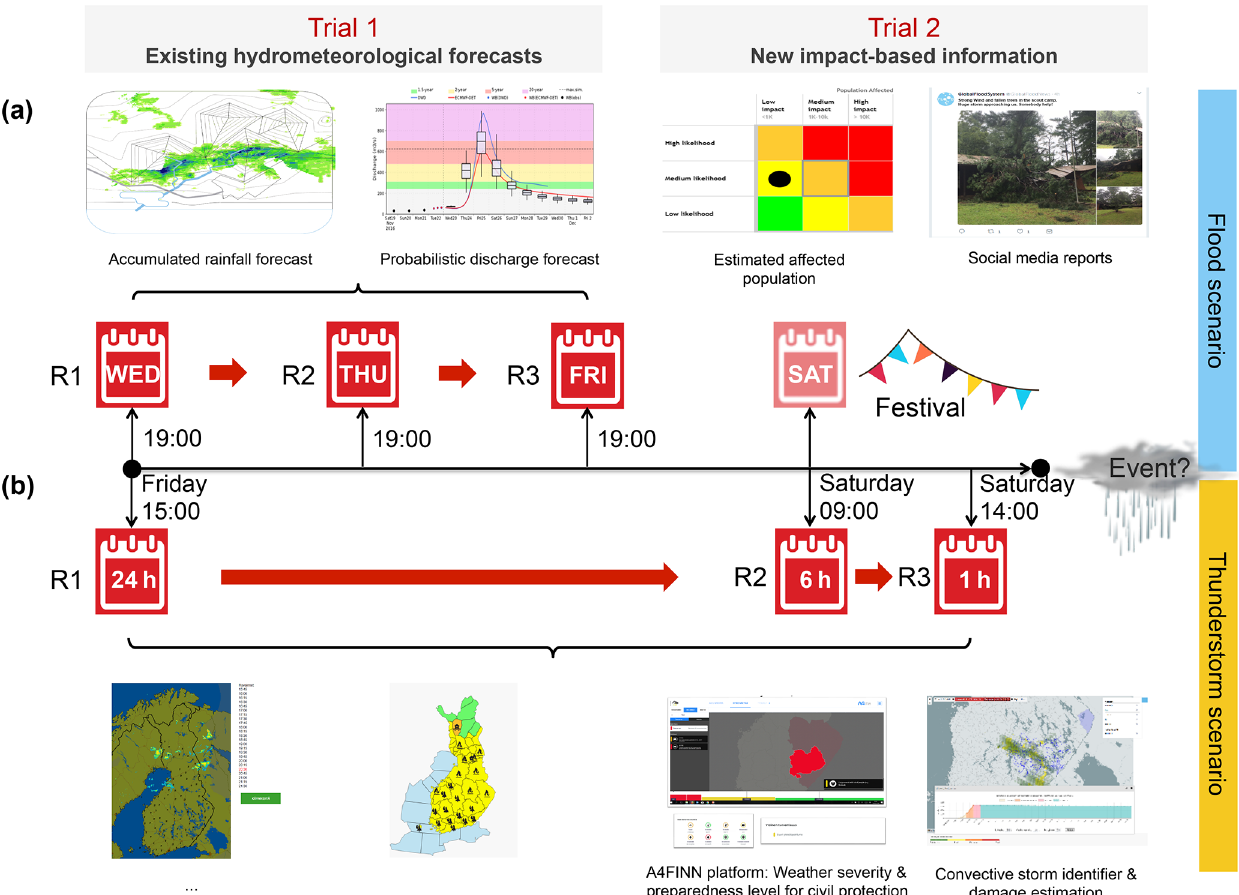
Figure 3. Schematic illustration of the gaming timeline (rounds 1 to 3) and the information provided to the players of ANYCaRE for the (a) flood scenario and (b) strong-wind scenario. Each of the three game rounds (R1–R3) played in the experiments corresponds to a daily or hourly time step before the festivals that, according to the storylines, are held on Saturday. In the second trial of each round, the players receive additional decision-support tools including high-resolution forecasts and impact-based vulnerability